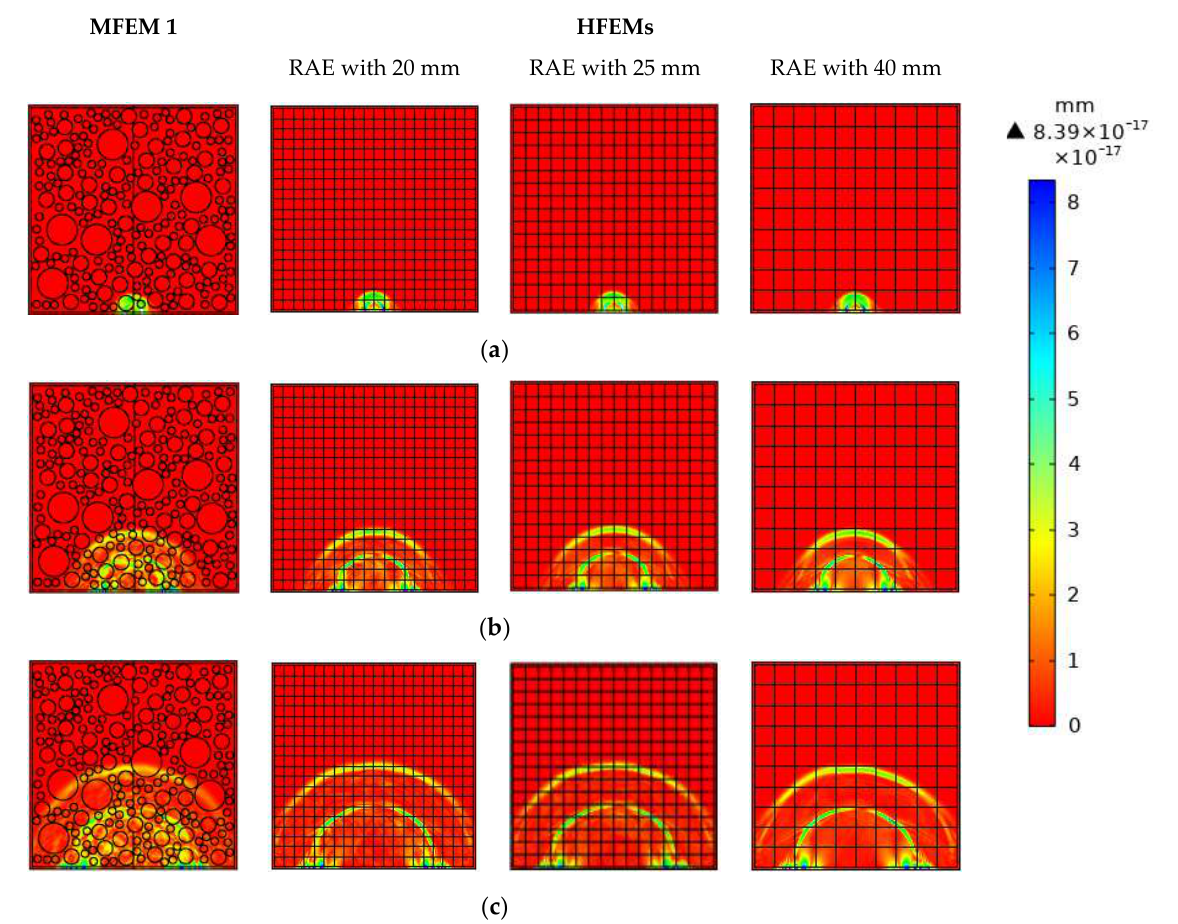
Figure 4. Stress wave fields of MFEM 1 and its corresponding HFEMs with different RAE dimen-sions at different times: ( a ) t = 1 × 10 −5 s; ( b ) 3 × 10 −5 s; ( c ) t = 5 × 10 −5 s.